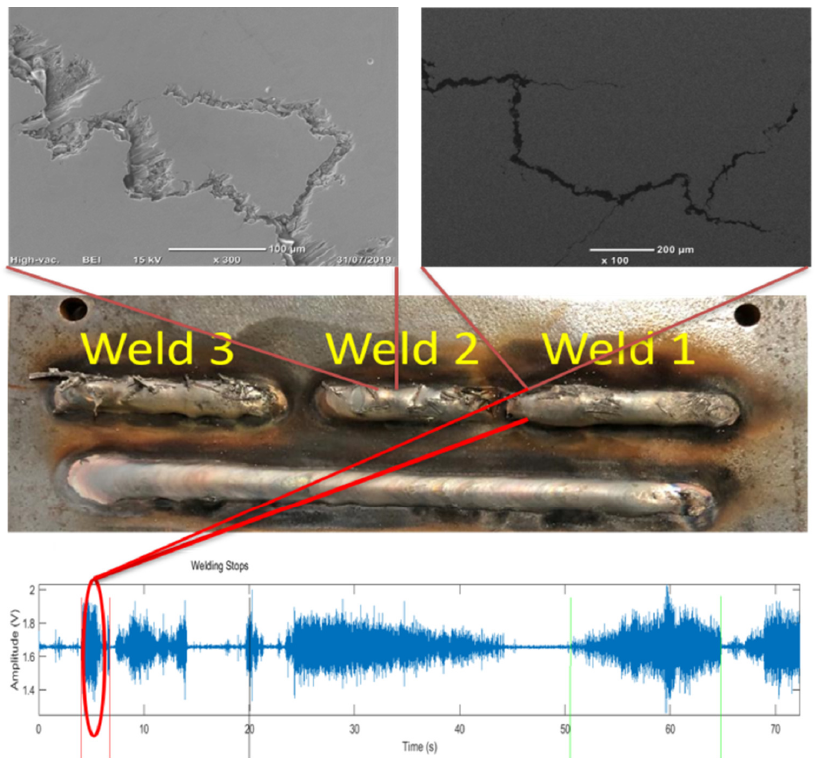
Figure 8. Confirmation of cold cracks from SEM imaging and its correlation with time domain response [73,74].